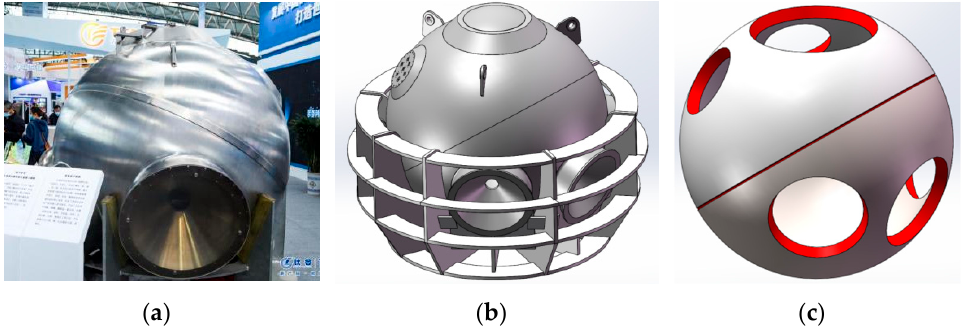
Figure 1. Manned cabin of 10,000 m ‐ class submersible made in China: ( a ) actual photograph, ( b ) structure of the spherical pressure hull of the manned cabin with outside frame for heat treatment, and ( c ) distribution of welding on spherical pressure hull of the manned cabin.